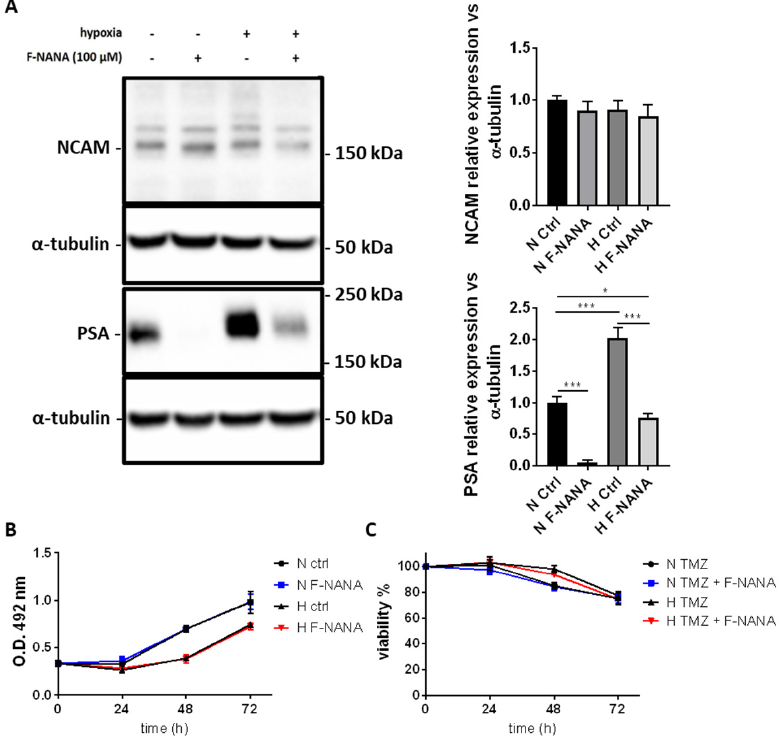
Figure 3. Effects of F-NANA on the proliferation, chemoresistance to TMZ and levels of NCAM and PSA in U87-MG cells under hypoxia. ( A ) Western blot analysis showing the expression of NCAM and PSA in U87-MG cells grown either under normal or low oxygen concentrations, in presence or not of 100 µ M F-NANA. ( B ) MTS assay showing the proliferation (expressed as absorbance at 492 nm) of U87-MG cells exposed for 72 h either to chronic hypoxia or normoxia, in presence or not of 100 µ M F-NANA. ( C ) Viability evaluation in U87-MG cells grown either in normoxia or hypoxia and treated with 200 µ M TMZ, in presence or not of 100 µ M F-NANA. All results are expressed as the mean ± SD of three independent experiments. *: p < 0.05; ***: p < 0.001.